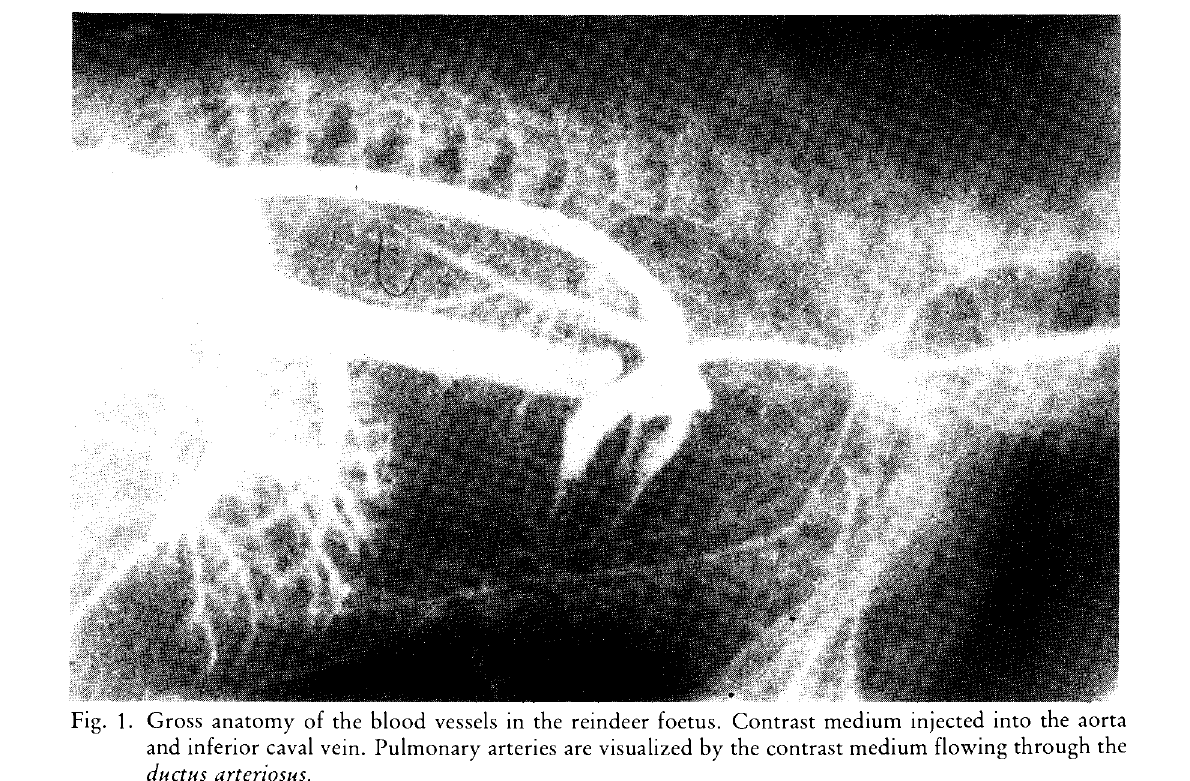
Fig. 1. Gross anatomy of the blood vessels in the reindeer foetus. Contrast medium injected into the aorta and inferior caval vein. Pulmonary arteries are visualized by the contrast medium flowing through the ductus arteriosus.